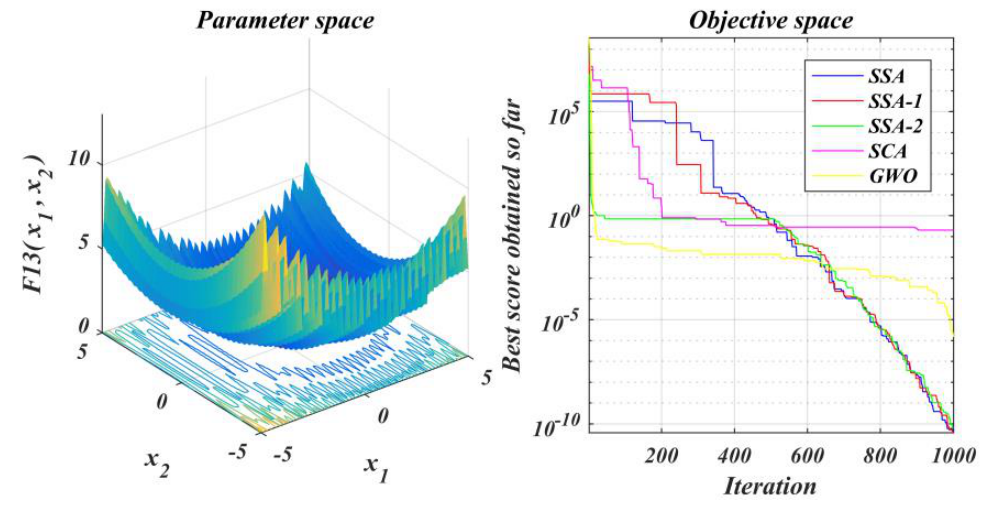
Figure 5. F10 Convergence curve.